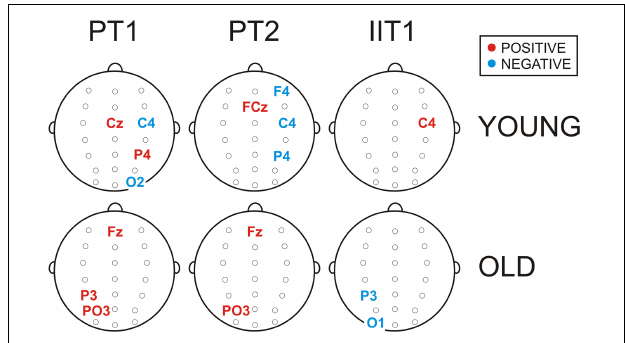
FIGURE 4 | Schematic illustration of electrode positions at which SCPs were extracted by regression models as positive (in red) or negative (in blue) predictors ( p < 0.05) of T1 preparation (PT1), T2 preparation (PT2), and input interference (IIT1) for the groups of young and old adults. Statistical details are presented in Supplementary Table 3